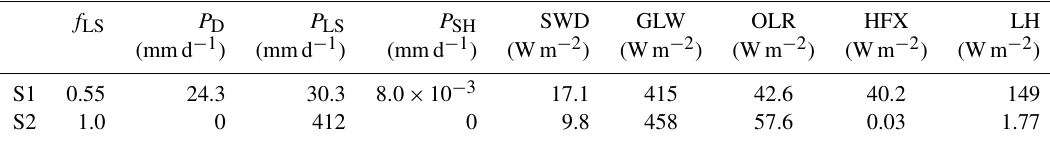
Figure 8. Potential precursor activity for the second and third abrupt transitions. (a) Left axis: temperature ( T ) evolution (blue). Right axis: raindrop number concentration evolution (red) with low-pass filtering shown in black. (b) Left axis: water vapor mixing ratio ( q ) evolution (blue). Right axis: the rainwater mixing ratio evolution (red) with low-pass filtering shown in black. All quantities are at p ≈ 835mb. Table 4. Average values for various quantities for the S1 and S2 states from the f LS → 1 experiment shown in Fig. 9. After f LS , the three types of precipitation (deep-convective P D , large-scale P LS , and shallow-convective P SH ) are shown, followed by the shortwave radiation to the surface (SWD), the outgoing longwave radiation from the ground (GLW), the outgoing longwave radiation at the top of the column (OLR), and the surface sensible (HFX) and latent (LH) heat